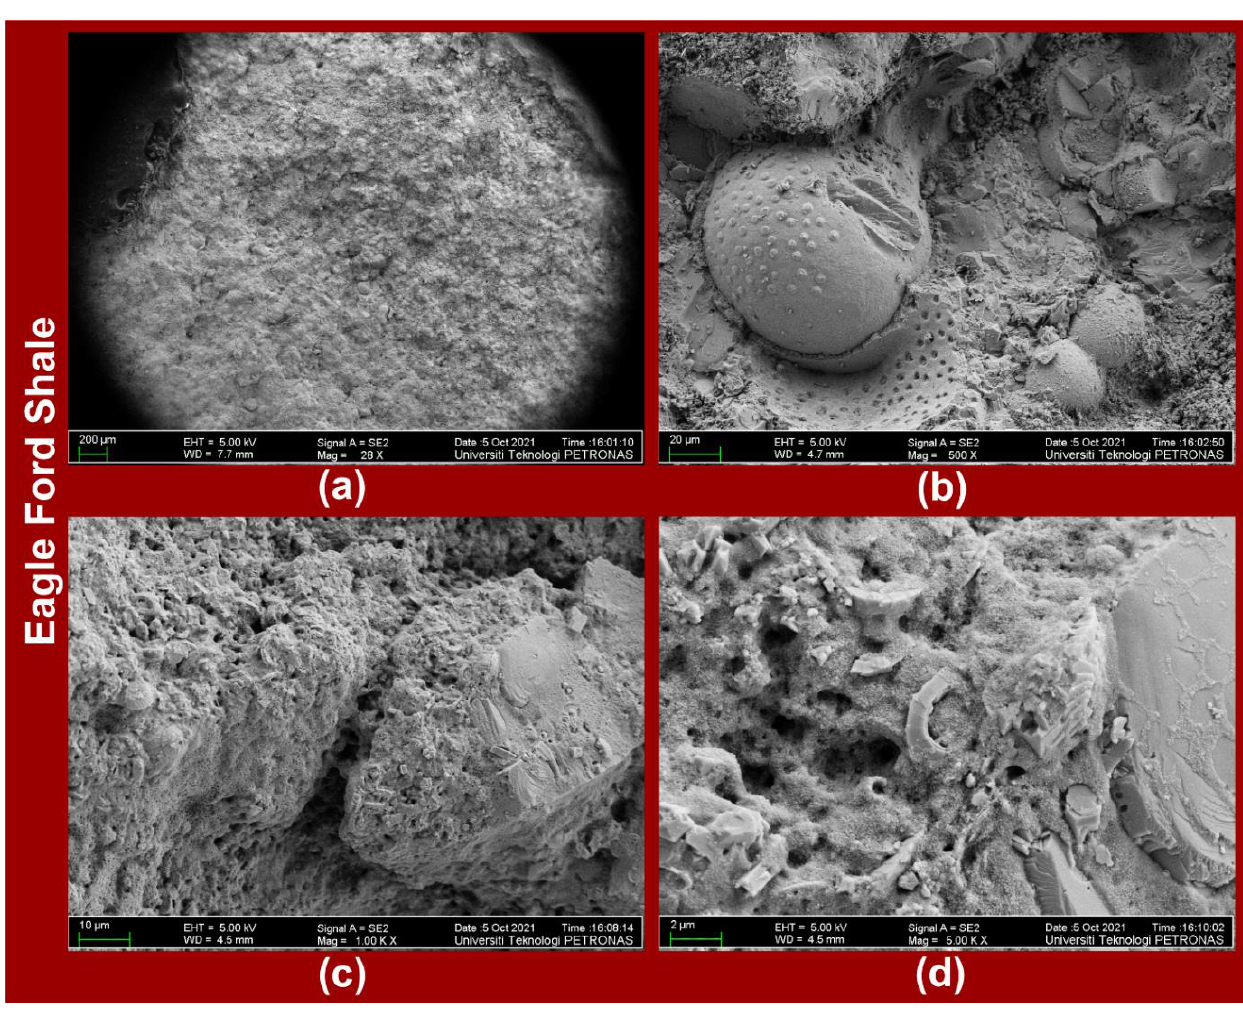
Figure 8. FESEM images of Eagle Ford shale at magnifications of ( a ) 28X, ( b ) 500X, ( c ) 1000X, and ( d ) 5000X.